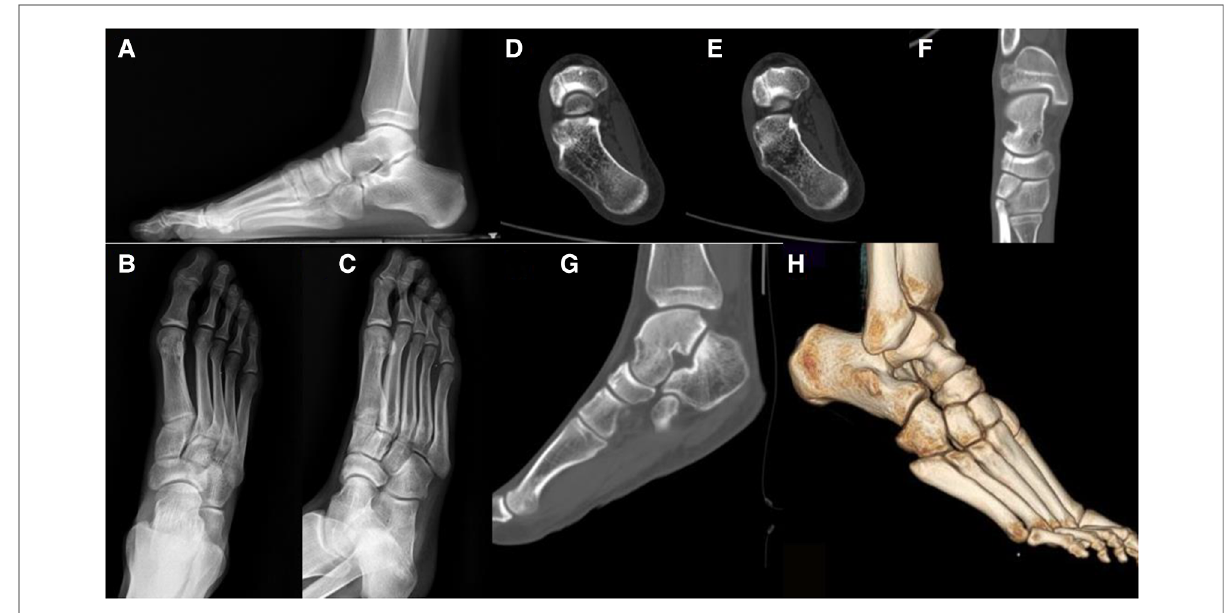
FIGURE 2 Preoperative imaging data of the right foot showed a tarsal navicular fracture of the right foot (Sangeorzan Type III.2). The fracture line extended from dorsolateral to plantar, and the medial column was stable. ( A ) Weight-bearing lateral radiographs of the right foot; ( B ) anteroposterior x-ray of the right foot; ( C ) oblique radiography of the right foot; ( D,E ) CT axial view of the right foot; ( F ) CT coronal view of the right foot; ( G ) CT sagittal view of the right foot; ( H ) 3D CT reconstruction of the right